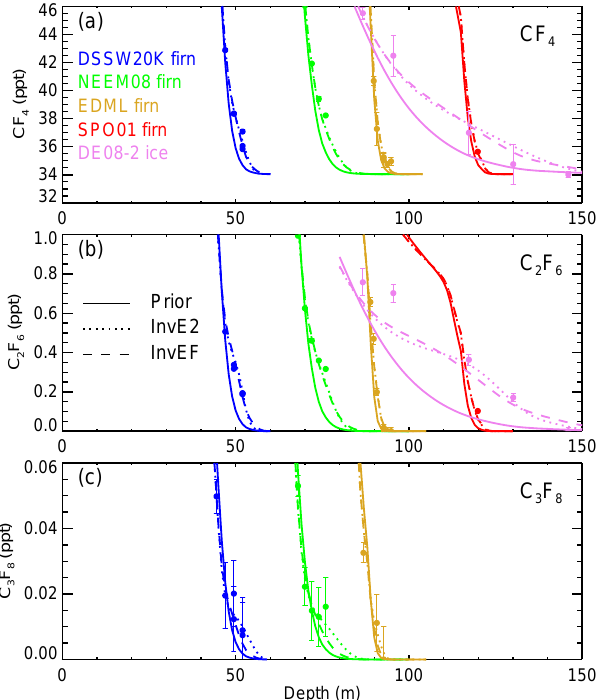
Figure 6. Mole fraction depth profiles at the bottom of the firn and in the DE08-2 ice for (a) CF 4 , (b) C 2 F 6 and (c) C 3 F 8 . Solid lines show mole fraction depth profiles for the prior, dotted lines are InvE2 emissions and dashed lines are for InvEF emission factor. Symbols show measurements with 1 σ uncertainties.